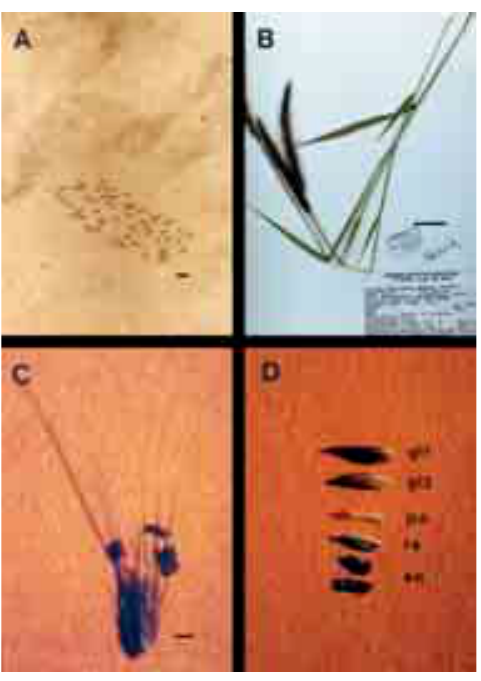
Figure 6 - Wild BAG 15 ( P. af. orientale ). A. Mitotic metaphase with 2n=36 chromosomes; B. Specimens; C. Spikelet; D. Constituent of the spikelet: an (anthers), le (lemma), pa (palea), gl4 (4 th glume), gl3 (3 rd glume),gl2(2 nd glume),gl1(1 st glume)Thebarsrepresent:A.5 µ m;B.5.6 cm; C and D. 2.3 mm. UFLA. Lavras, MG, Brazil, 1998.